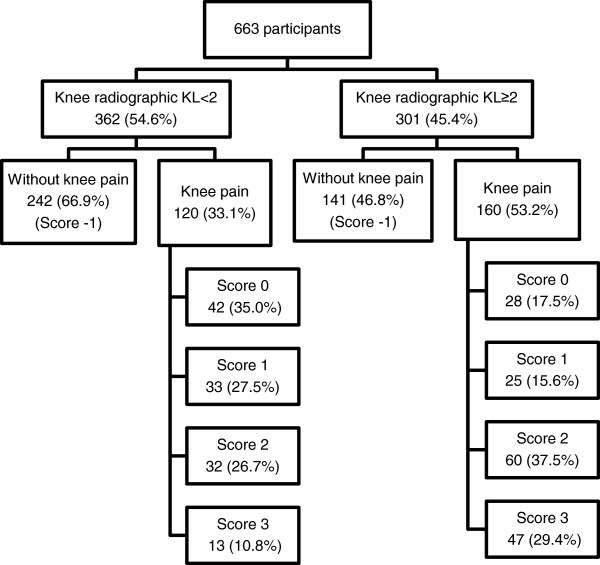
Distribution of participants according to knee pain and radiographic findings.